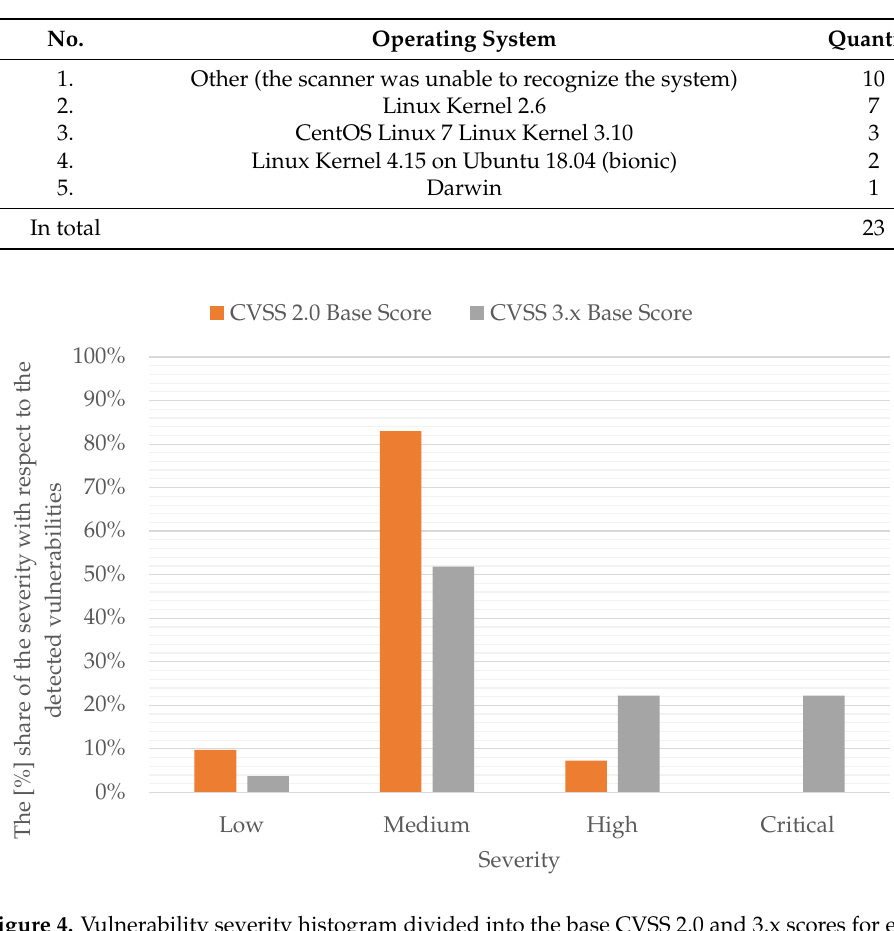
Table 1. Numbers and types of operating systems detected in environment A.